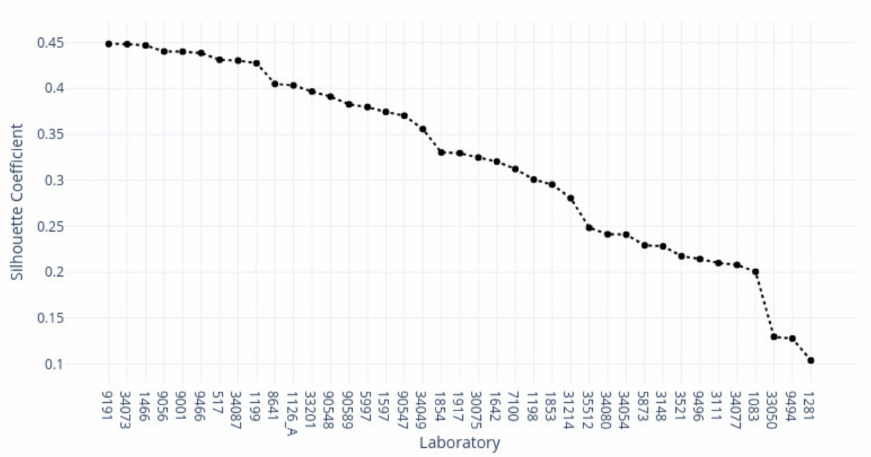
Figure 15. Silhouette scores for the second found cluster (C2) in skin samples across